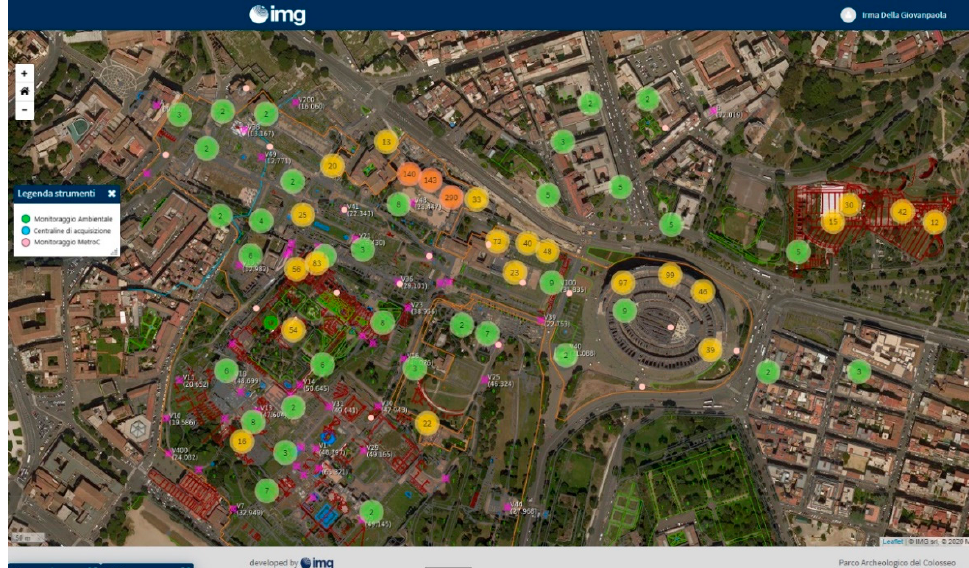
Figure 10. Census of measurement devices (IMG): mapping of areas with environmental monitoring systems (about 1000 in total).